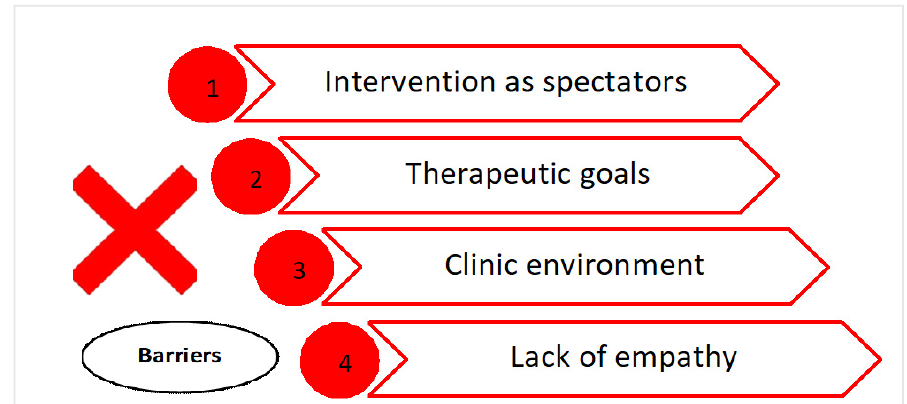
Figure 4. Barriers present in the UCP early intervention from the families’ perspectives.